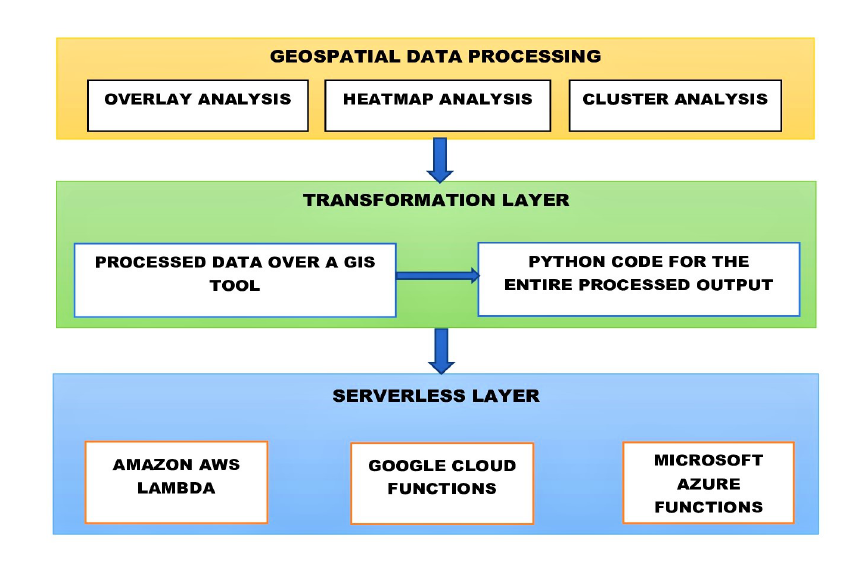
Figure 5. Proposed framework for deploying geospatial serverless computing.